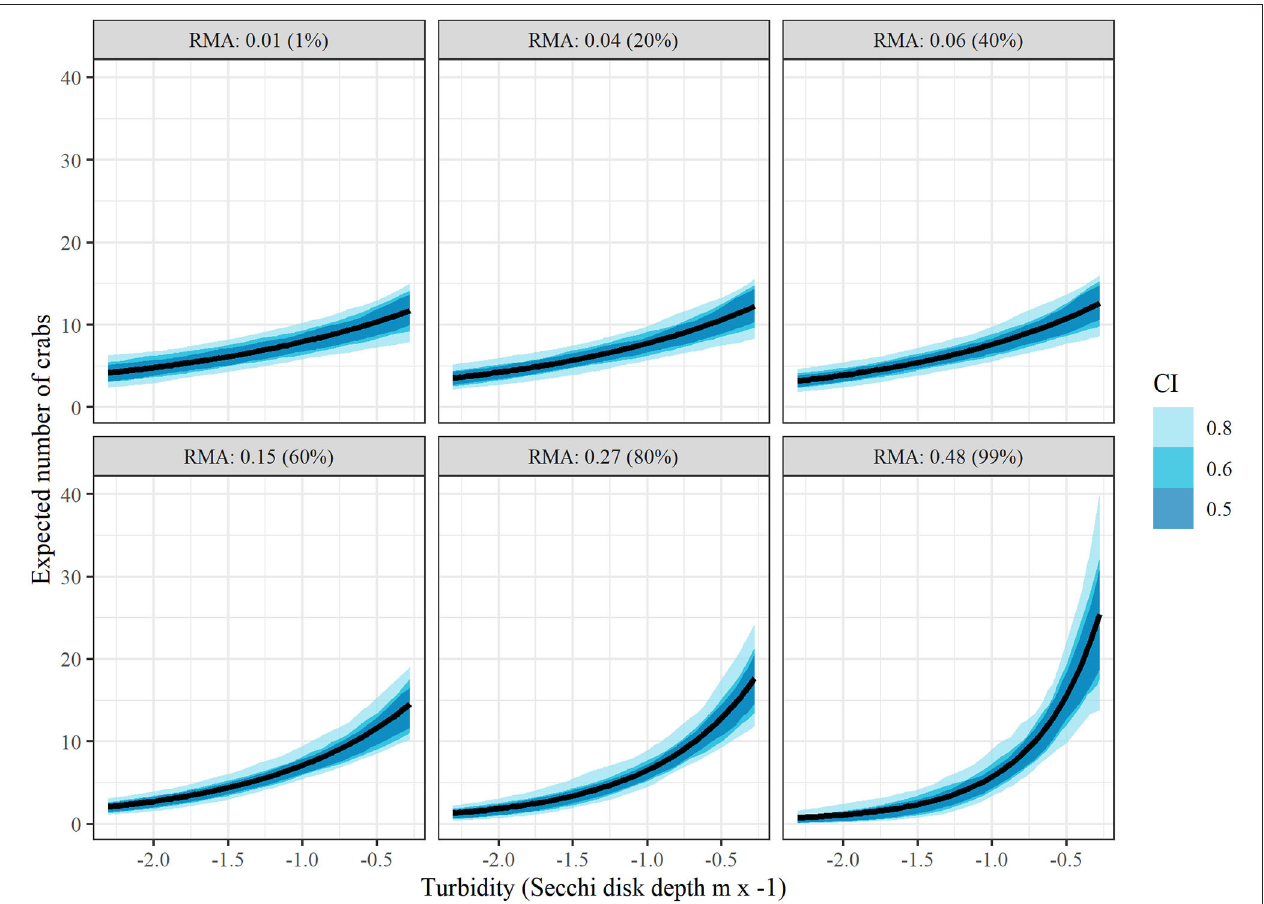
FIGURE 6 | Conditional effects plots depicting relationship between juvenile blue crab abundance per 1000 m towed ( µ cond ) vs turbidity at relative marsh area (RMA) values corresponding to 1, 20, 40, 60, 80, and 99% percentiles to visualize interaction effects between relative marsh area and turbidity on crab abundance. All other continuous variables were held at 0 and categorical variables at the James River (tributary) and post 2008 (management). Colored bands indicate Bayesian confidence bands of µ cond . (See the Drivers of Juvenile Blue Crab Abundance Section for definitions).